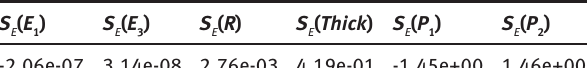
Table 5 Reliability sensitivity with the mean value of random variables.